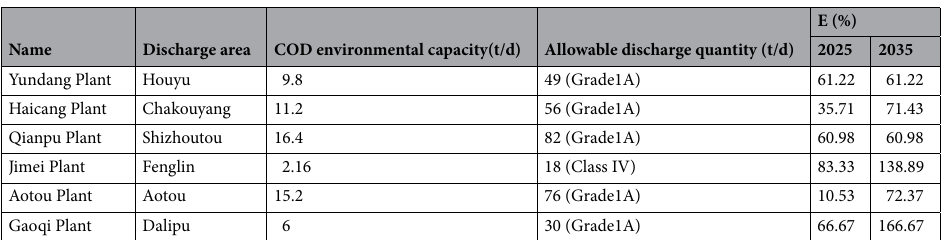
Table 6. COD environmental capacity utilization (E) of each outfall in different